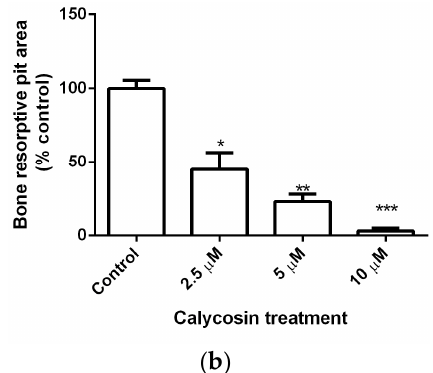
Figure 2. Effects of calycosin on the generation of bone resorption pits. ( a ) BMMs were cultured with indicated dose of calycosin in the presence of M-CSF (20 ng/mL) and RANKL (20 ng/mL) on Corning Osteo Assay Surface 24 well plates. After six days, cells were removed using 5% sodium hypochlorite and staining by Von Kossa method with modified; and ( b ) the areas were quantified by Image J. The results were expressed as means ± SD from three independent experiments. Scale bar represents